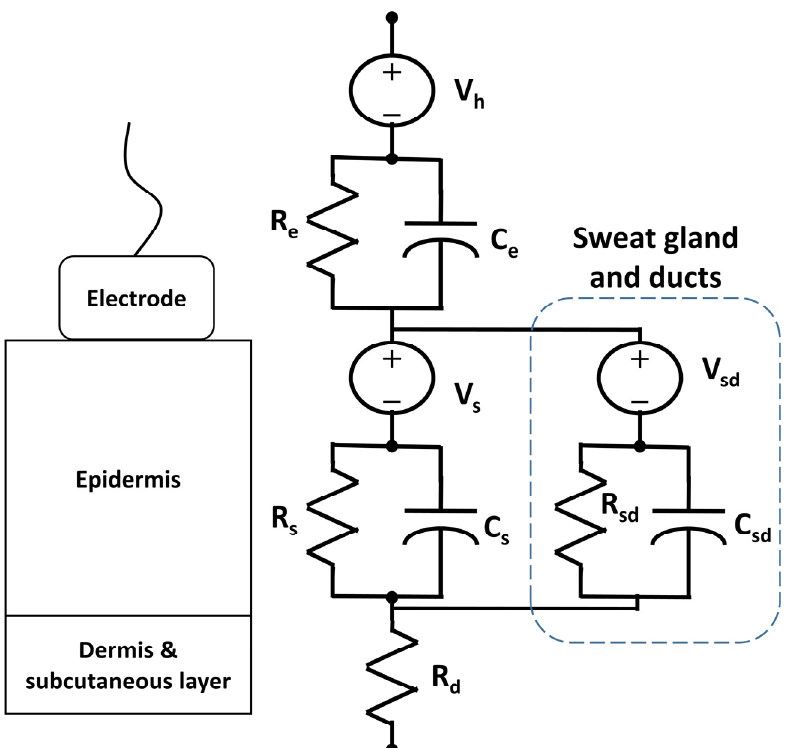
Figure 4. Electrical model of electrode-skin interface for electrodermal